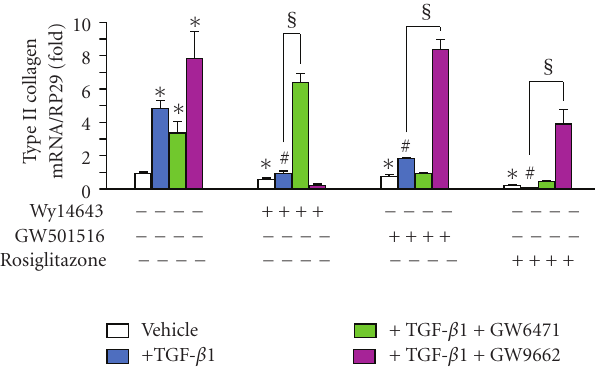
Figure 6: Selective reversion of anti-TGF- β 1 potency of PPAR agonists on type II collagen mRNA expression in rat chon- drocytes . Chondrocytes, embedded in alginate beads (5.10 4 cells per bead), were pretreated for 2h with Wy14643 (100 μ M), GW501516 (100 nM), or rosiglitazone (10 μ M), before stimulation with 10ng/mL TGF- β 1 for 48h. Normalized collagen type II mRNA levels were quantified by real-time PCR ( n = 4). Data were expressed as mean ± SEM and statistically significant di ff erences from the control were indicated as ∗ P < . 05; from TGF- β 1-treated cells as # P < . 05; from “TGF- β 1+agonists”-treated cells as § P < . 05 .